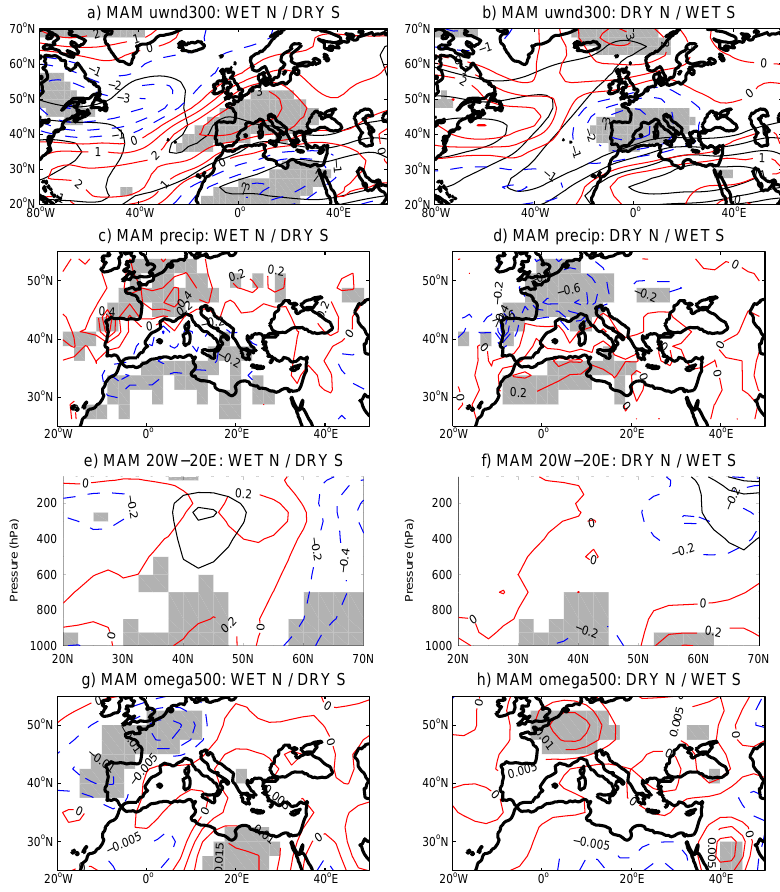
Fig. 13. Same as Fig. 11, but for spring: years when the northern Mediterranean was wetter and the southern Mediterranean was drier than normal in the left panels; years when the northern Mediterranean was drier and the southern Mediterranean was wetter than normal in the right panels.